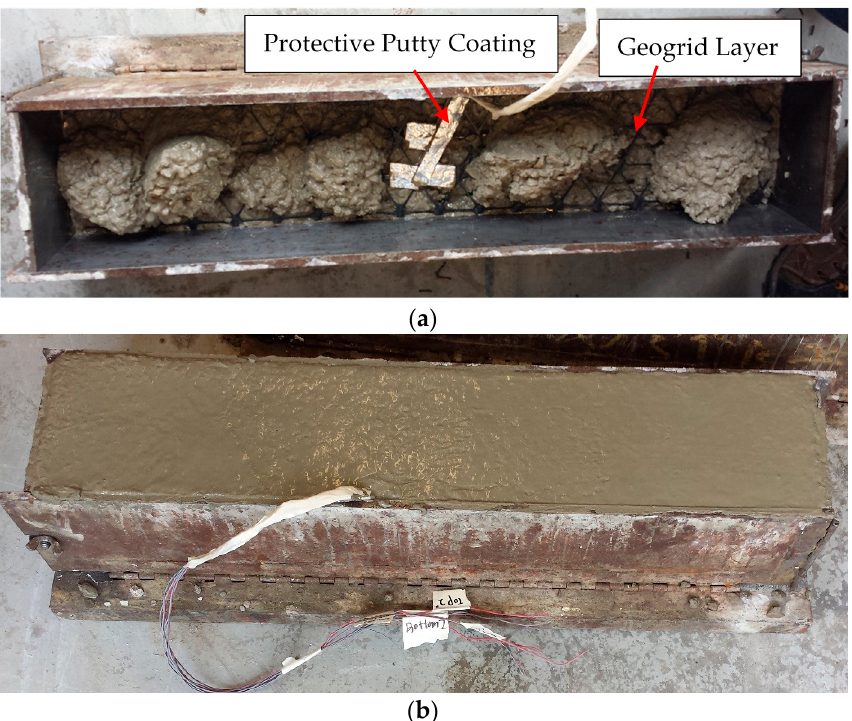
Figure 2. Fabrication of geogrid-reinforced beams: ( a ) cast the second layer of concrete mixture upon placing the geogrid; ( b ) finished concrete beam specimen with strain gages wires labelled.